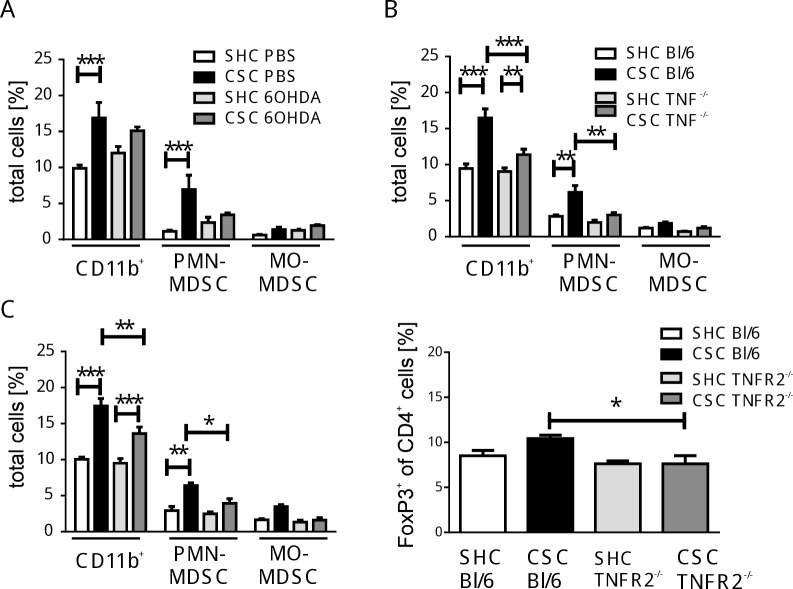
Involvement of catecholamines, TNF, or TNFR2 on CSC-caused cellular shifts.(A) Mice were treated either with PBS or 6-OH dopamine (6OHDA) before induction of CSC/SHC. Splenocytes from individual PBS-treated SHC (white bars, n = 4, total splenocytes: 3.4±0.6x107) and CSC mice (black bars, n = 3, total splenocytes: 4.1±1.6x107), 6OHDA-treated SHC (light grey bars, n = 4, total splenocytes: 4.1±0.7x107) and CSC mice (dark grey bars, n = 3, total splenocytes: 6.3±1x107) were isolated after 19d of SHC/CSC and analyzed by flow cytometry. The percentages of CD11b+ cells (SHC/PBS: 3.3±0.6x106; CSC/PBS: 6.9±2.7x106; SHC/6OHDA: 4.9±0.8x106; CSC/6OHDA: 9.5±0.2x106), CD11b+Ly6G+Ly6Cint (PMN-MDSC, SHC/PBS: 0.4±0.1x106; CSC/PBS: 2.9±1.1x106; SHC/6OHDA: 1.0±0.2x106; CSC/6OHDA: 2.1±0.0x106), and CD11b+Ly6G-Ly6Chigh (MO-MDSC, SHC/PBS: 0.2±0.03x106; CSC/PBS: 0.6±0.2x106; SHC/6OHDA: 0.5±0.1x106; CSC/6OHDA: 1.2±0.02x106) were determined. (B) Wild type (Bl/6) or TNF-deficient (TNF-/-) mice were exposed to SHC/CSC. The percentages of CD11b+ cells, PMN-MDSC, and MO-MDSC of individual Bl/6-SHC- (white bars, n = 4, total splenocytes: 4.2±1.7x107), Bl/6-CSC- (black bars, n = 3, total splenocytes: 8.9±2.4x107), TNF-/—SHC (light gray bars, n = 6, total splenocytes: 6.9±1.3x107), and TNF-/—CSC-mice (dark grey bars, n = 5, total splenocytes: 9.3±1.9x107) were quantified. The percentages of CD11b+ cells (SHC/Bl/6: 4.0±1.6x106; CSC/Bl/6: 16.1±4.0x106; SHC/TNF-/-: 6.4±1.4x106; CSC/TNF-/-: 10.8±2.4x106), CD11b+Ly6G+Ly6Cint (PMN-MDSC, SHC/Bl/6: 1.2±0.5x106; CSC/Bl/6: 6.0±1.5x106; SHC/TNF-/-: 1.4±0.3x106; CSC/TNF-/-: 2.9±0.1x106), and CD11b+Ly6G-Ly6Chigh (MO-MDSC, SHC/Bl/6: 0.5±0.3x106; CSC/Bl/6: 1.8±0.5x106; SHC/TNF-/-: 0.5±0.1x106; CSC/TNF-/-: 1.1±0.2x106) were determined. (C) Wild type (Bl/6-SHC, n = 3, white bars, total splenocytes: 7.1±1.5x107; Bl/6-CSC, n = 4, black bars, total splenocytes: 9.5±2.1x107) or TNFR2-deficient (TNFR2-/- SHC, n = 4, light gray bars, total splenocytes: 6.3±1.2x107; TNFR2-/- CSC, n = 4, dark grey bars, total splenocytes: 5.1±0.9x107) mice were exposed to SHC/CSC. The percentages of CD11b+ cells (SHC/WT: 7.1±1.5x106; CSC/WT: 17.8±3.9x106; SHC/TNFR2-/-: 5.9±1.1x106; CSC/TNFR2-/-: 6.9±1.2x106), PMN-MDSC (SHC/WT: 2.0±0.4x106; CSC/WT: 6.1±1.3x106; SHC/TNFR2-/-: 1.6±0.3x106; CSC/TNFR2-/-: 2.0±0.4x106), and MO-MDSC (SHC/WT: 1.2±0.2x106; CSC/WT: 3.3+0.7x106; SHC/TNFR2-/-: 0.9±0.2x106; CSC/TNFR2-/-: 0.8±0.14x106)(left graph) or Treg cells (SHC/WT: 1.4±0.2x106; CSC/WT: 2.0±0.4x103; SHC/TNFR2-/-: 1.0±0.2x106; CSC/TNFR2-/-: 0.6±0.1x106)(right graph) were quantified. These experiments were performed twice. *p < 0.05; **p < 0.01; ***p < 0.001 (2way ANOVA).